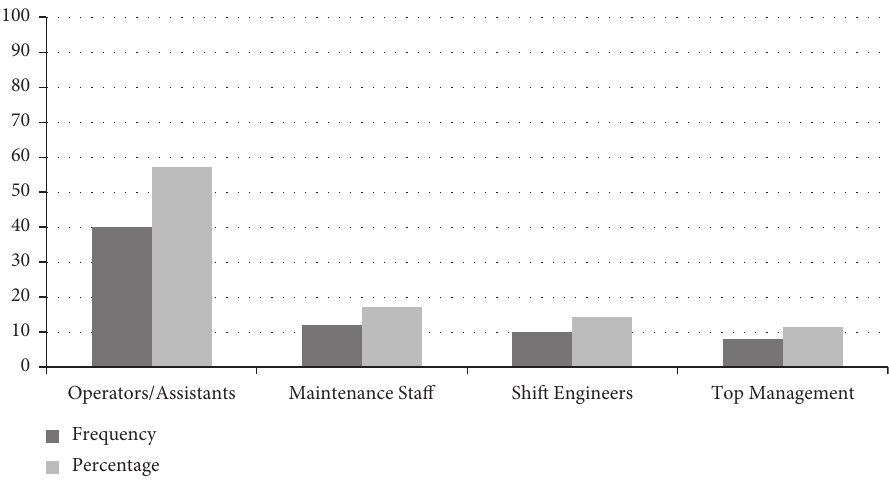
Figure 7: Respondents’ demographic profile for hierarchy stage. Table 4: Descriptive